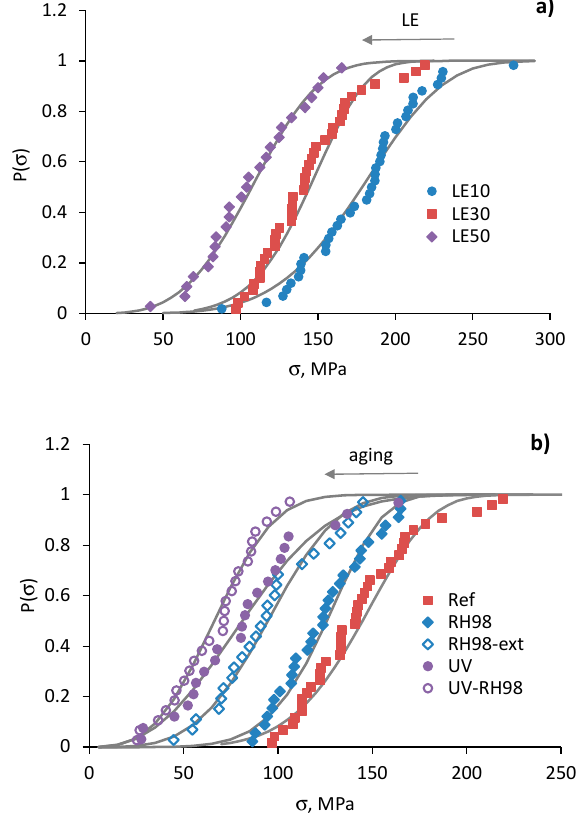
Figure 10. Strength distribution of the reference fibers of different gauge lengths ( a ) and fibers from different environments with LE = 30 mm ( b ). Lines are calculations by Equation (3).